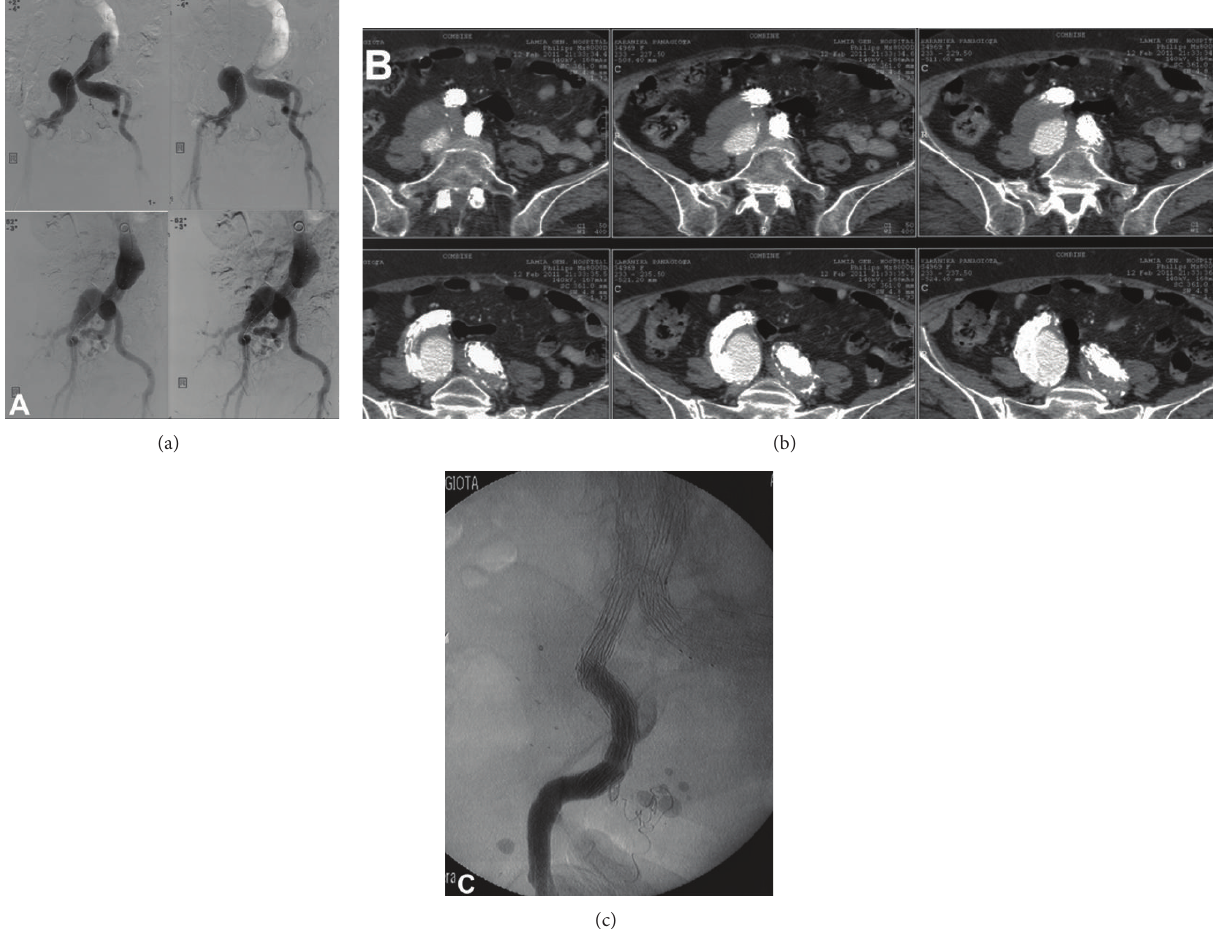
Figure 7: (a) A complex aortoiliac aneurismal pattern with bilateral CIAA and AAA. (b) Follow-up CT scan in one year showing endoleak type Ib in the flared right CIA and aneurysm sac expansion. (c) Completion angiography after right IIA embolization and extension stent grafts from right CIA to right EIA.